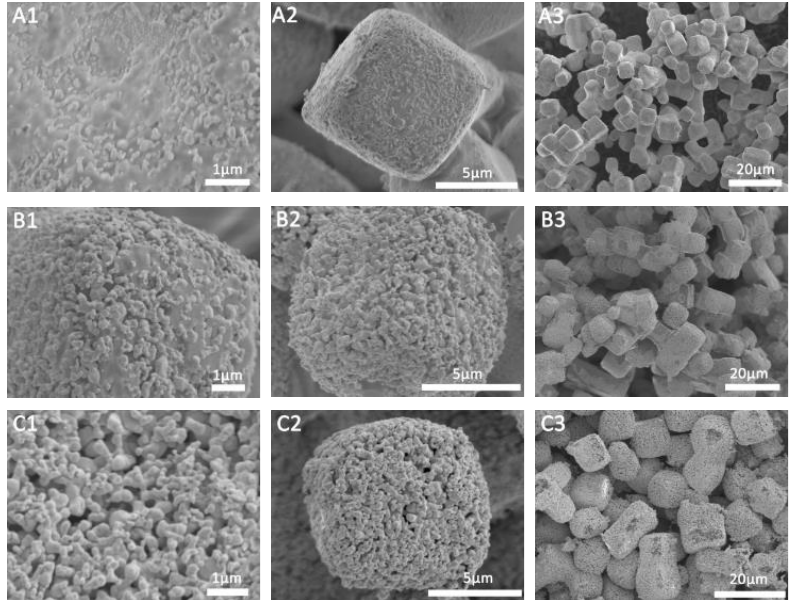
Figure 2. SEM images of different magnifications of porous Ag structure prepared when the ratio of NaBH4 to AgCl is 1:2 ( A1 – A3 ), 1:1 ( B1 – B3 ), 2:1 ( C1 – C3 ).